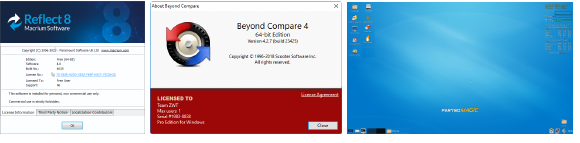
Figure 4 . Duplication, erasure, and restoration software Only after these processes are done, the system is considered to be “safe” and therefore legalized for the next mission.